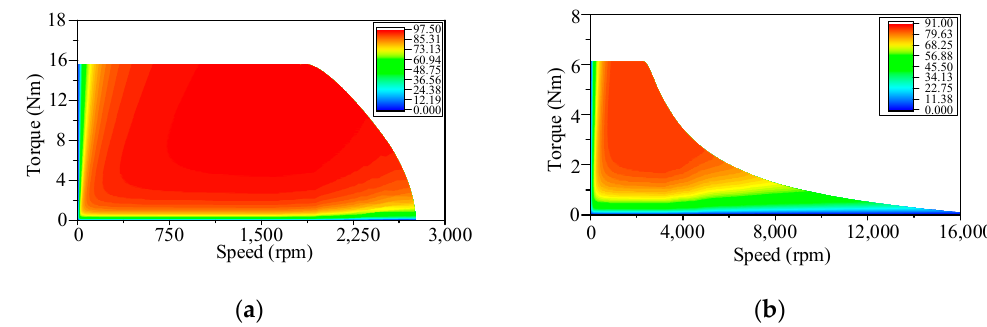
Figure 14. The efficiency maps of the two modes. ( a ) 8-pole mode. ( b ) 24-pole mode.